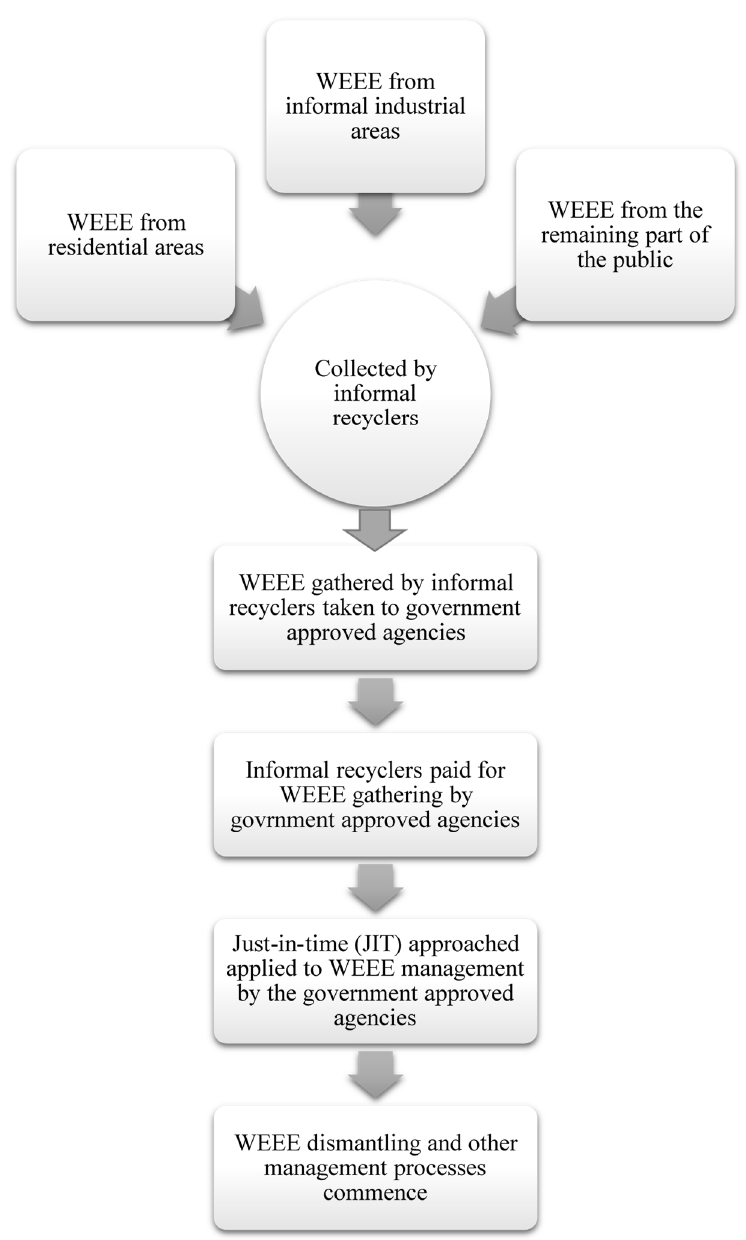
Figure 2. WEEE management model.